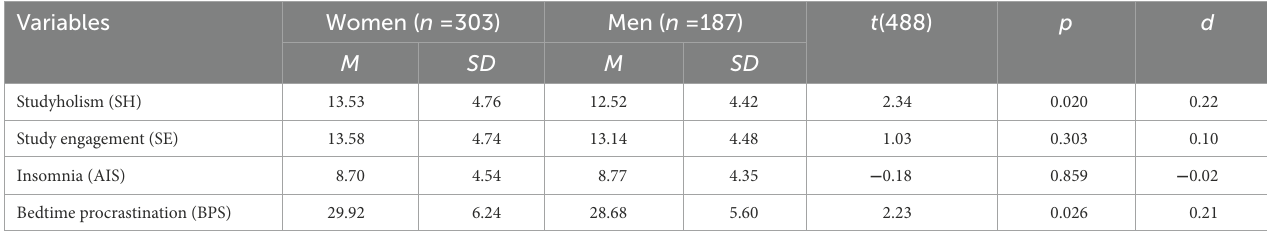
TABLE 4 Student’s t -test for gender differences in studyholism, study engagement, insomnia, and bedtime procrastination ( N = 495). Variables